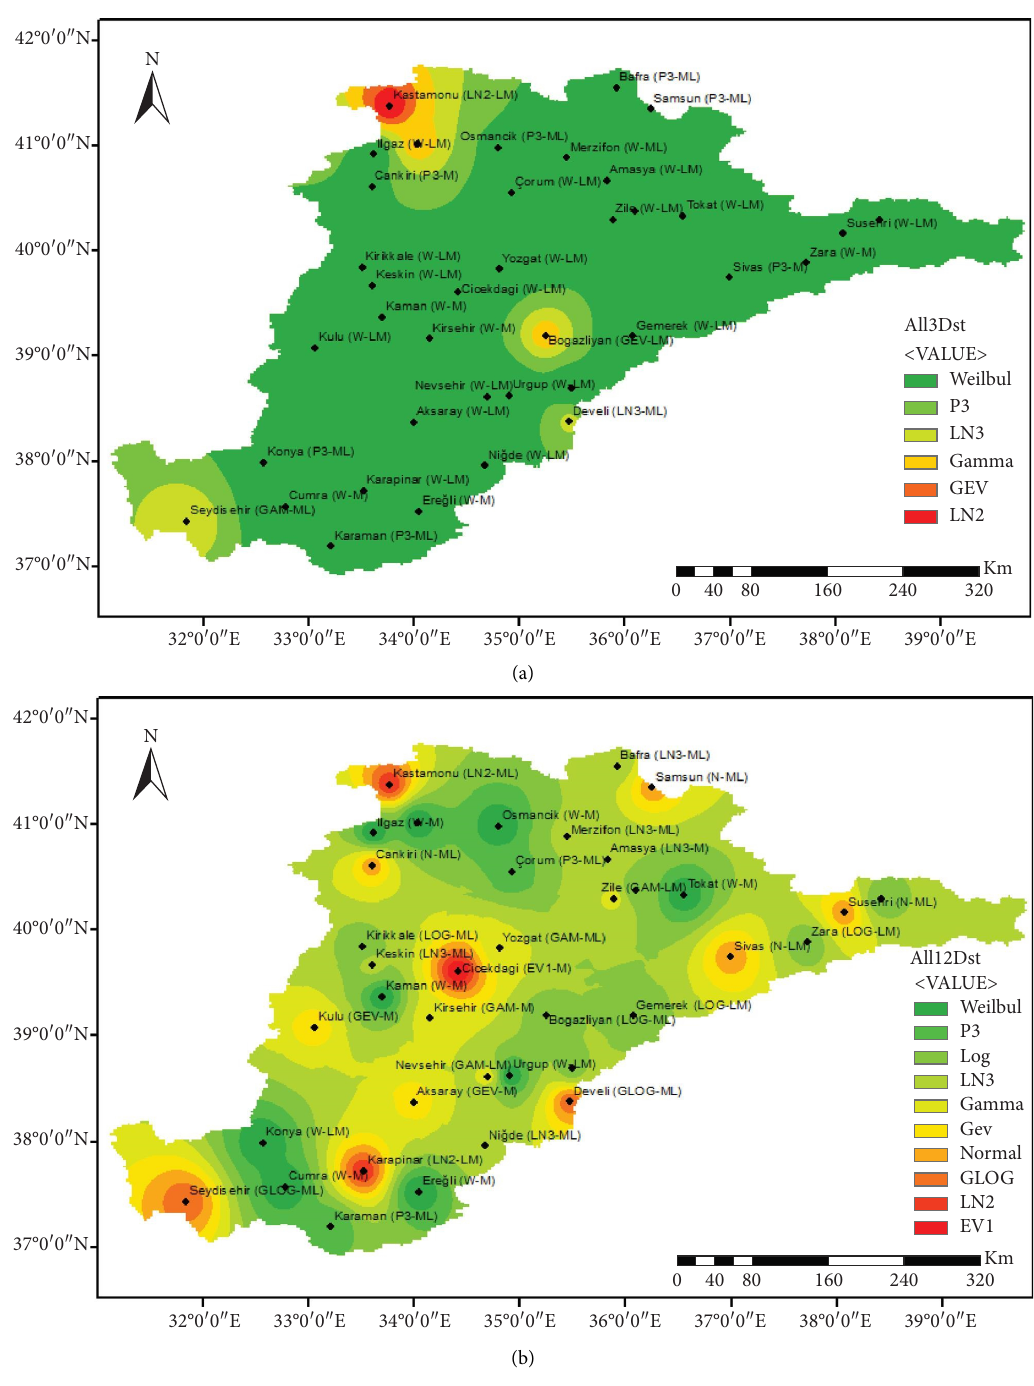
Figure 3: Spatial variability of the best-ft probability distribution models observed in the study region for (a) SPI3 and (b) SPI 12 drought